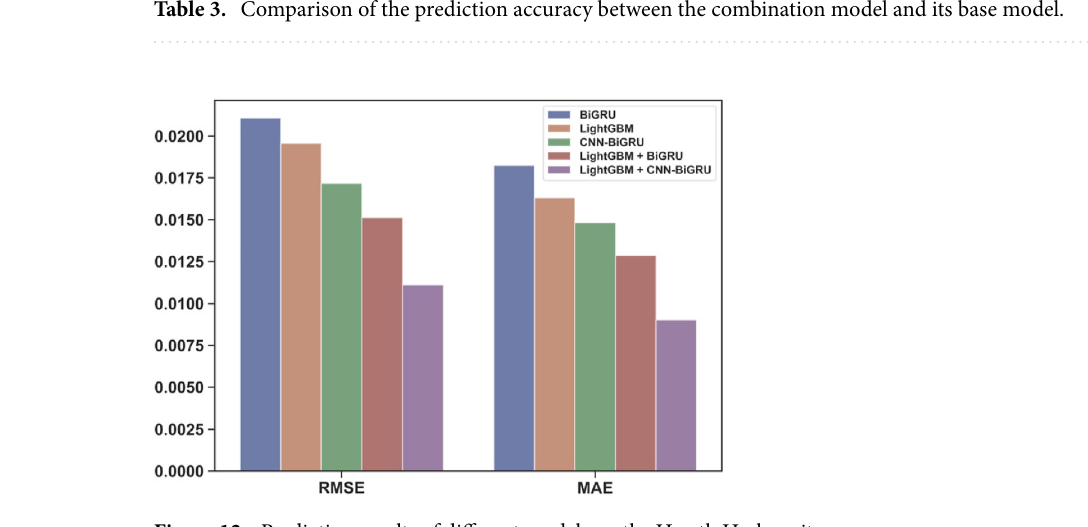
Table 3. Comparison of the prediction accuracy between the combination model and its base model.